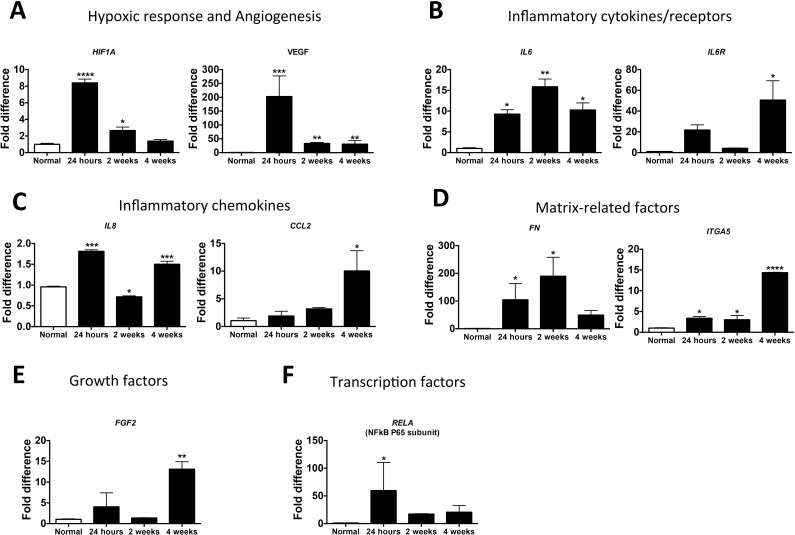
Selected index genes showed increased expression in the immature articular cartilage by qRTPCR analysis.The microarray results were validated by real-time qRTPCR analysis of the expression of selected index genes at 24 hours, 2 weeks and 4 weeks following the induction of ONFH. (A) The hypoxic response (HIFA, hypoxia inducible factor 1 alpha), angiogenesis (VEGFA, vascular endothelial growth factor alpha), (B) cytokines/cytokine receptors (IL6/IL6R, interleukin 6/interleukin 6 receptor), (C) chemokines (IL8, interleukin 8, CCL2, chemokine (C-C) motif ligand-2 (D) matrix related factors (FN, fibronectin; ITGA5, integrin alpha v subunit), (E) growth factors (FGF2, fibroblast growth factor-2) and (F) transcription factor (NFkB p65, nuclear factor kappa b, subunit p65) were confirmed by qRTPCR. The mRNA levels were normalized to 18sRNA and the data is shown as fold difference relative to normal articular cartilage. A total of n = 4 pigs were used per time point. Statistical analysis was performed using ANOVA and Tukey’s multiple comparison tests. P value * <0.05, **<0.01, ***<0.001, ****<0.0001